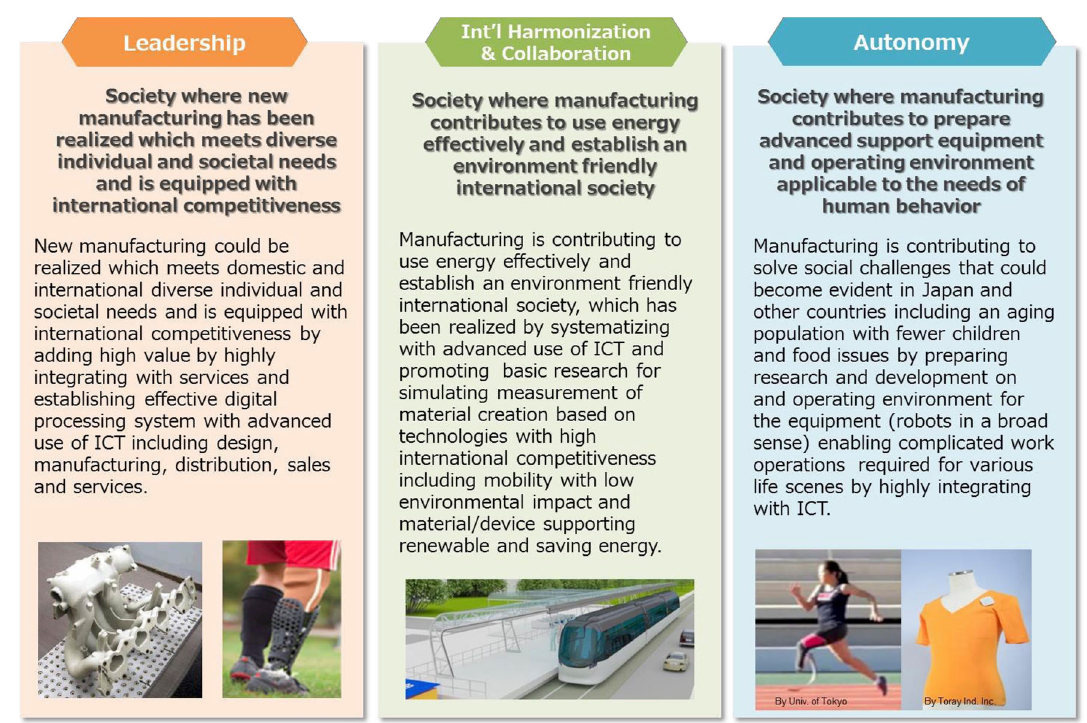
Fig. 2 Scenarios as the themes for manufacturing (Source: NISTEP